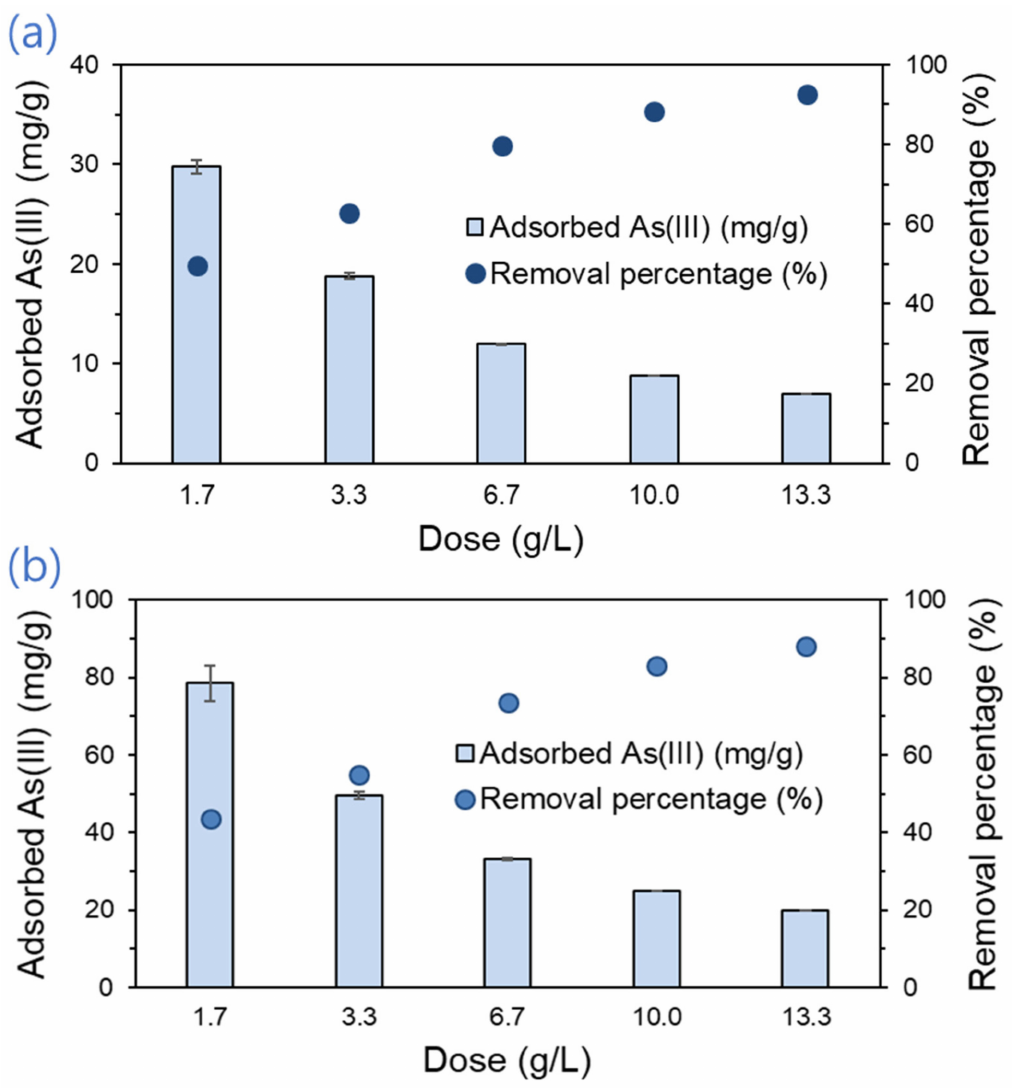
Figure 7. The effect of adsorbent dosage on As(III) adsorption on Al-FWB at ( a ) 100 mg/L and ( b ) 300 mg/L initial As(III)